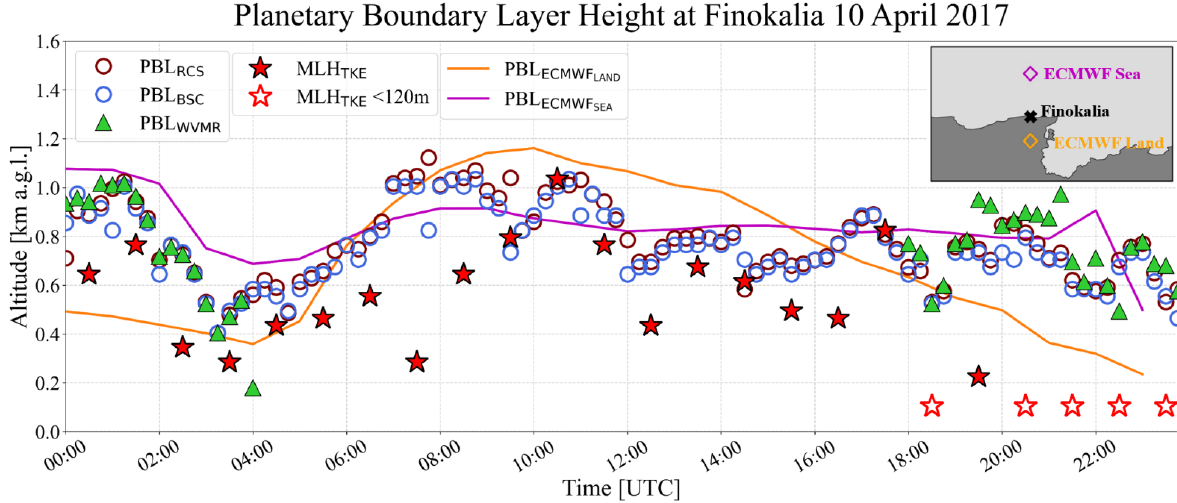
Figure 8. 10 April 2017 PBL height diurnal evolution from WCT applied on 532 nm NF RCS (brown circles — PBL RCS ), WVMR from PollyXT Lidar (green triangles — PBL WVMR ), BSC from Halo Lidar (blue circles — PBL BSC ) and TM applied on TKE dr from Halo Lidar (red stars — MLH TKE ). Top right: map with Finokalia’s location between ECMWF Land bin (orange diamond) and ECMWF Sea bin (purple diamond).